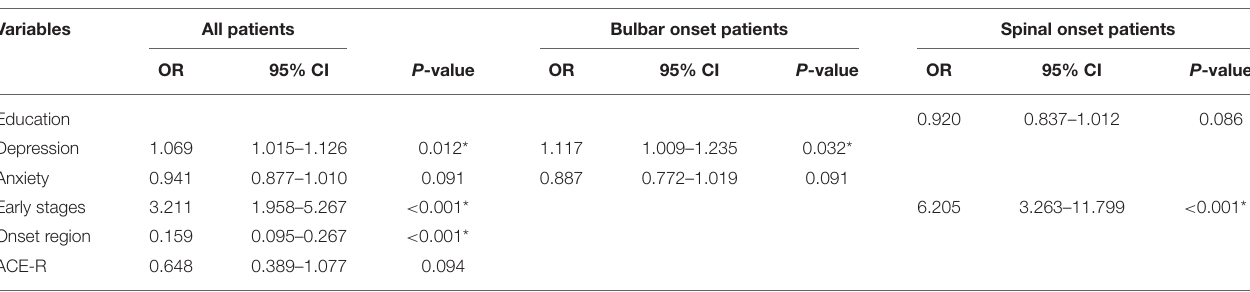
TABLE 3 | Factors associated with PLC in ALS patients with different onset region.